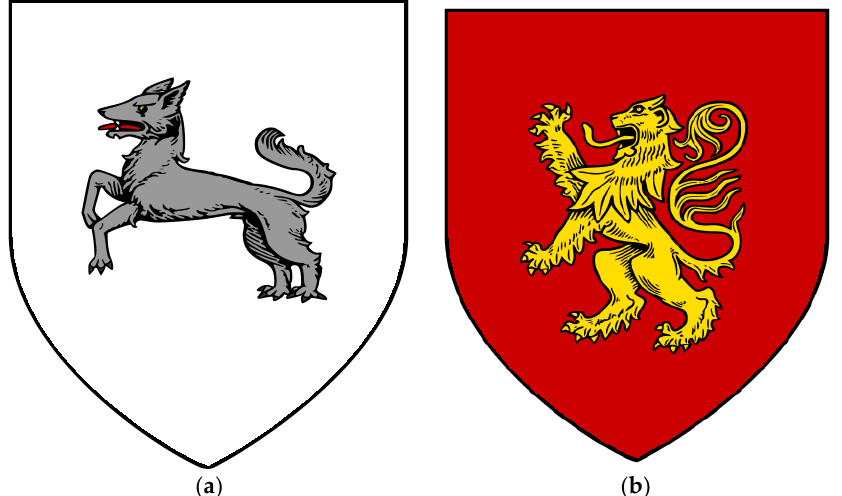
Figure 4. Simple designs of the Great Houses: ( a ) House Stark; ( b ) House Lannister.